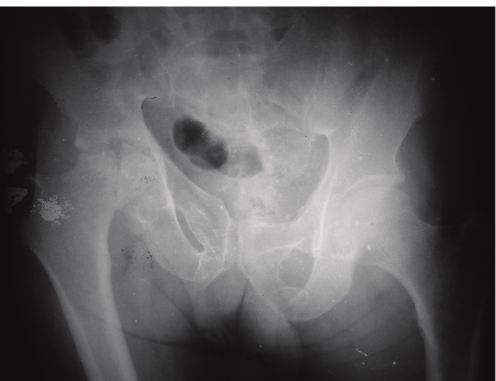
F 1: X-ray pelvis with both hips showing collapse of right femur head with fracture of head of femur. Evidence of old vertical shear type sacroiliac disruption right side is seen.